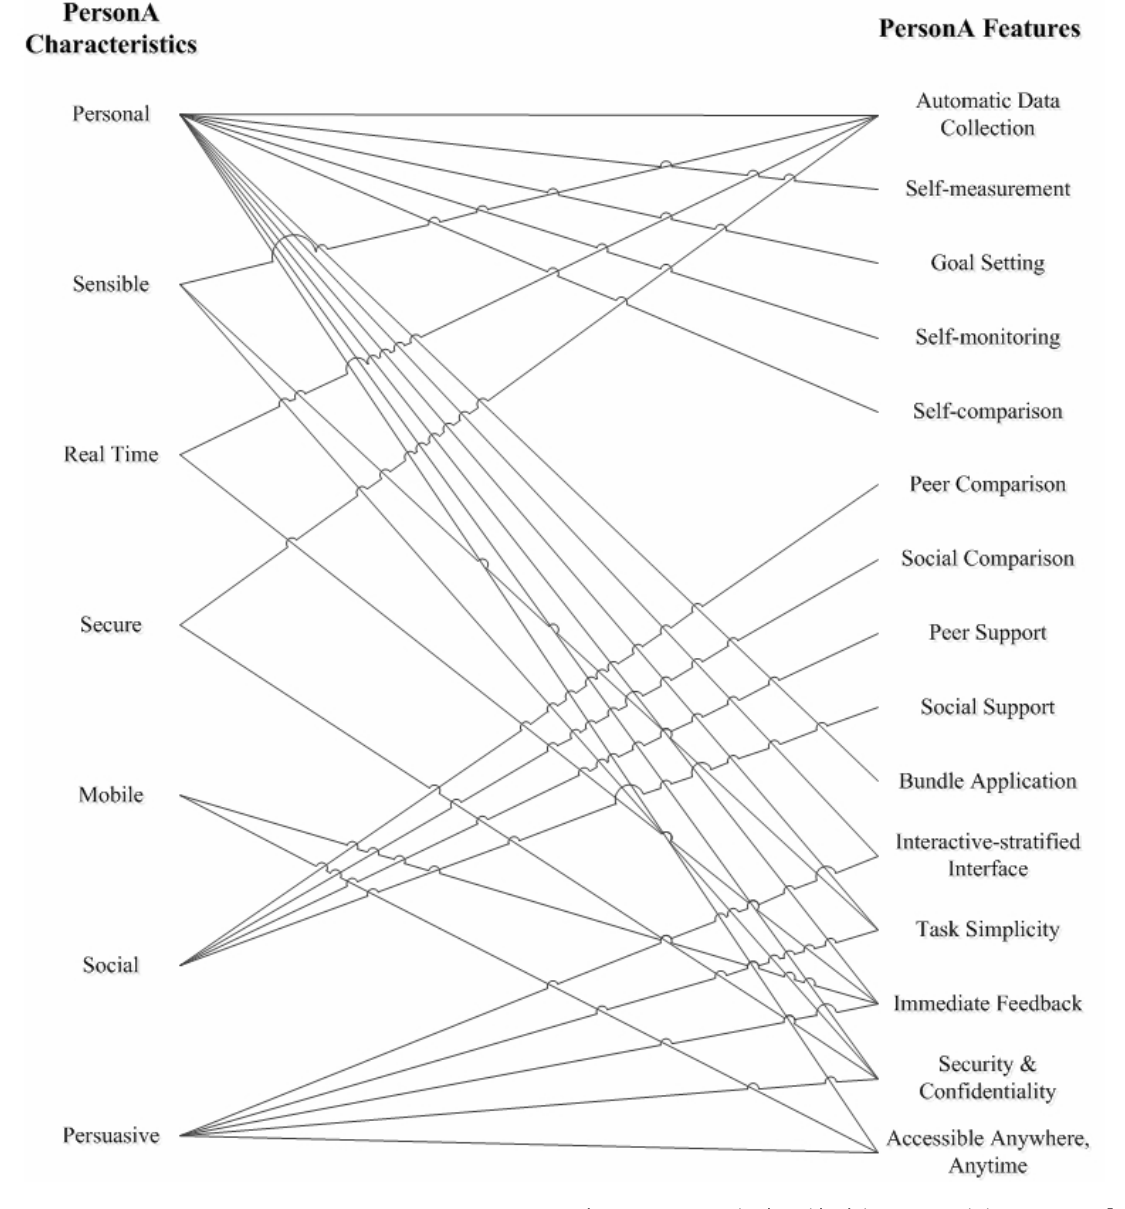
Figure 6. Relationships between PersonA Characteristics Model and PersonA